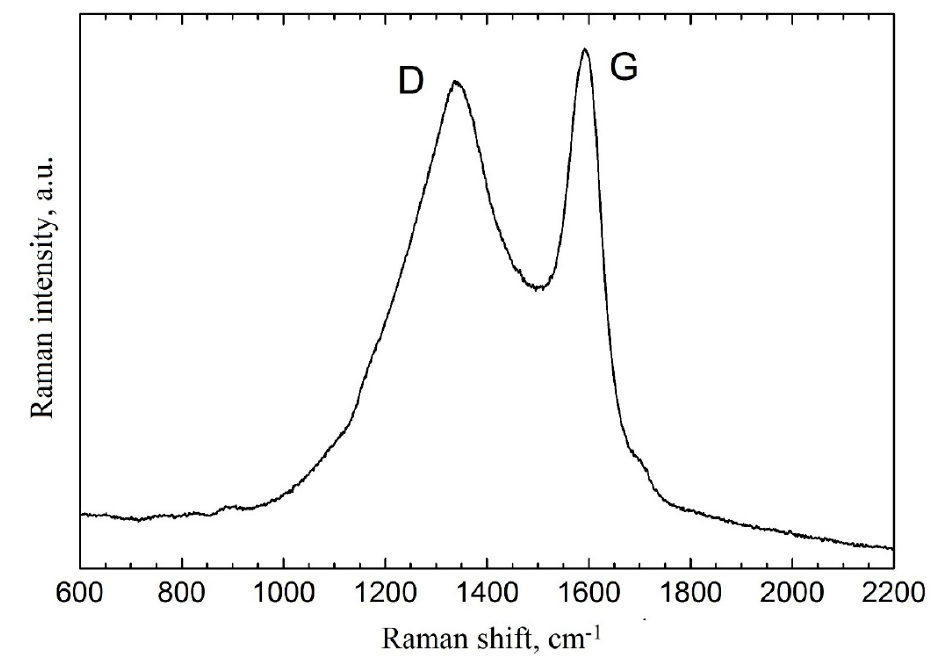
Figure 2. The Raman spectrum of the MC sample.